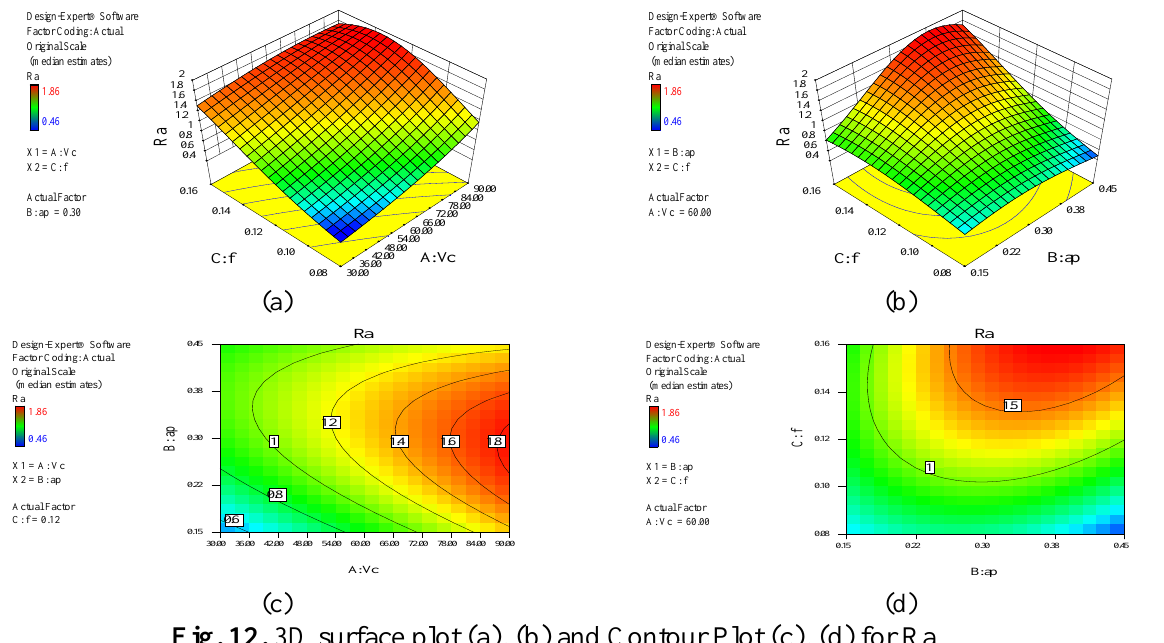
Fig. 12. 3D surface plot (a), (b) and Contour Plot (c), (d) for Ra